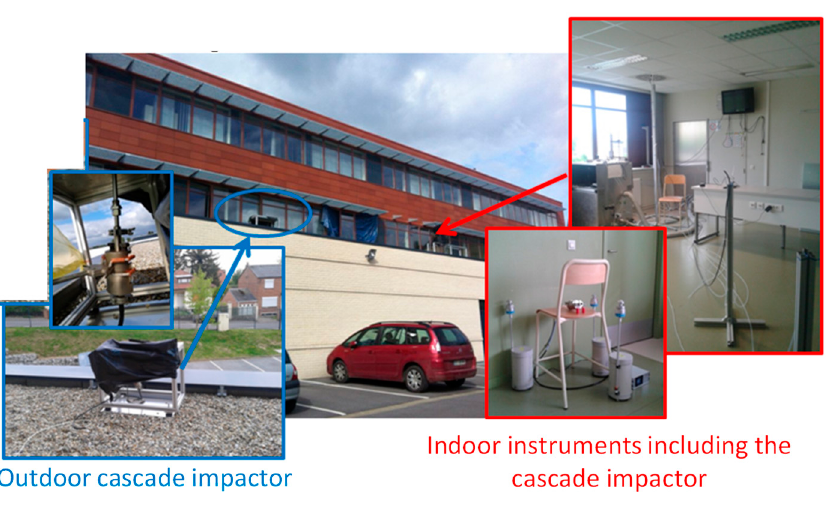
Figure 2. Pictures of the cascade impactors installed either inside the investigated classrooms (red) or outdoors (blue) during the field campaign. or outdoors (blue) during the field